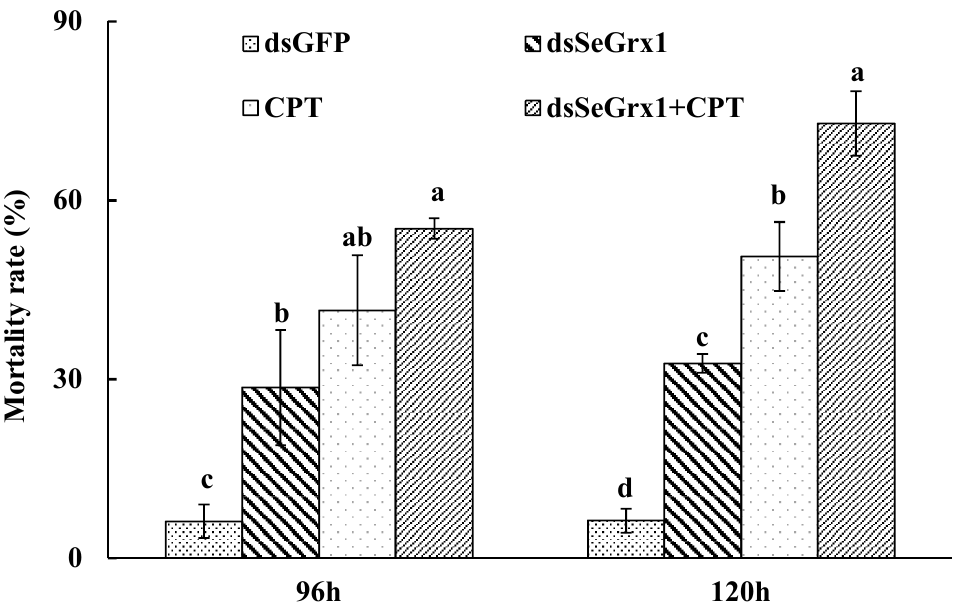
Figure 5. Mortality of S. exigua larvae treated by dsRNA and/or CPT at 96 h and 120 h. Values are shown as mean ± SEM. Data followed by the same lowercase letters among different treatments at the same time indicate no significant difference at 0.05 level.